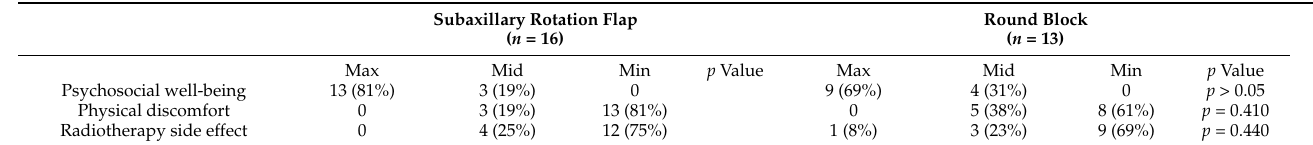
Table 6. Quality of